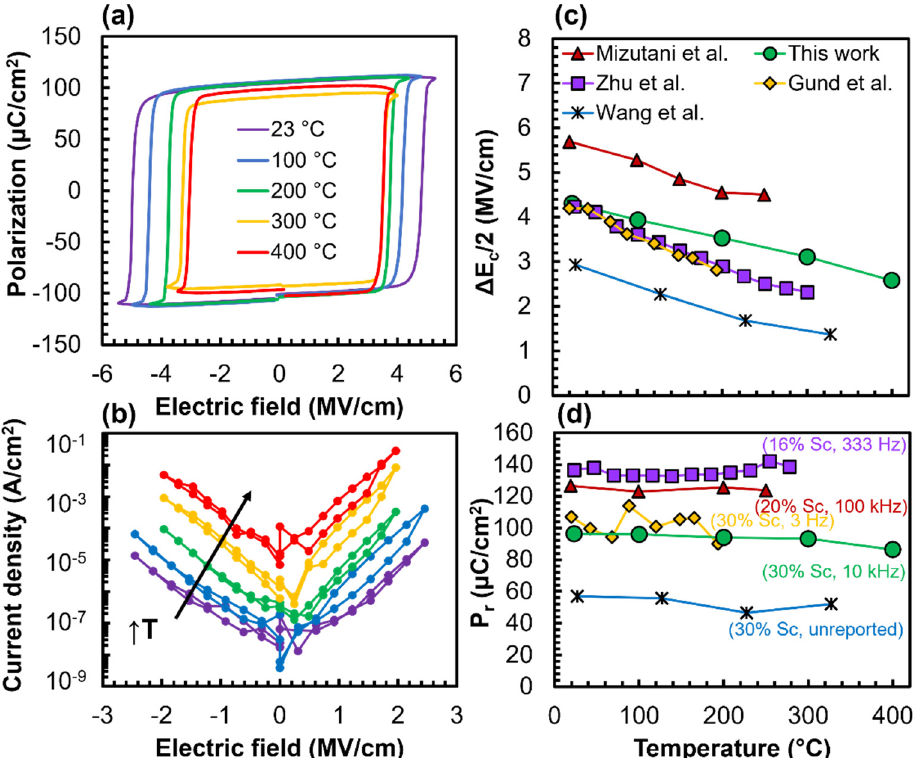
Figure 3. ( a ) P − E loops between 23 and 400 °C collected with 10 kHz bipolar voltage waveform. ( b ) Temperature − dependent leakage current density (J) over bias between 23 and 400 °C. Comparison of ( c ) ∆ E c /2 and ( d ) P r results from this work with Mizutani et al. [21], Zhu et al. [20], Gund et al. [22], and Wang et al. [20]. The results in ( a , b ) are from this work, while ( c , d ) are a comparison of our results with previous